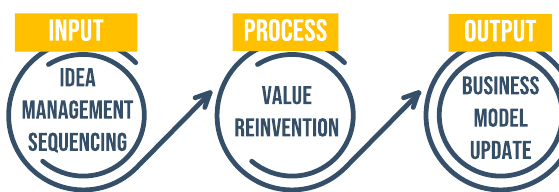
Fig. 3 The theoretical framework of this research (source: the authors)